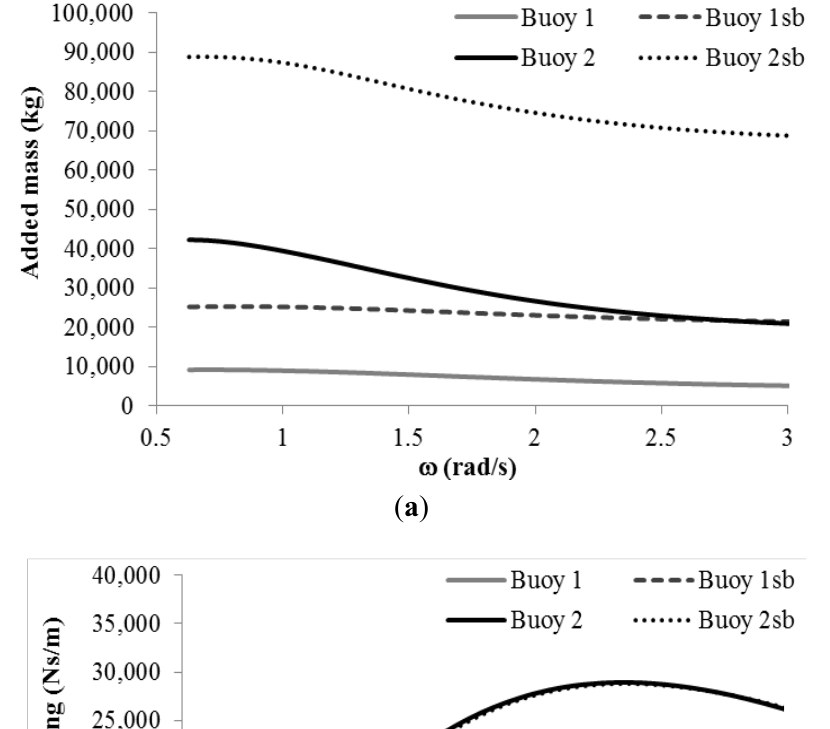
Figure 3. Hydrodynamic parameters of the four buoy configurations: ( a ) added mass; ( b ) radiation damping; ( c ) excitation force